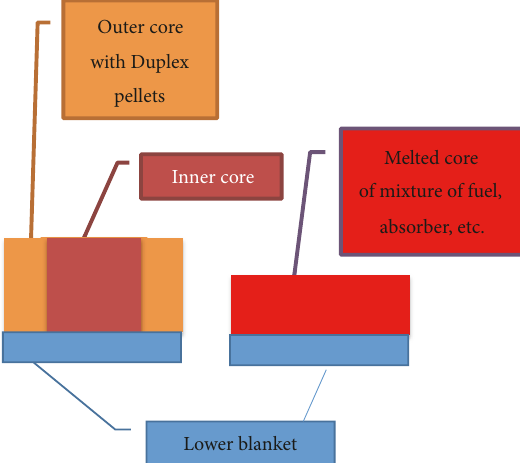
Figure 2: Concept of recriticality prevention with Duplex pellet with neutron absorber in the outer core of the fast